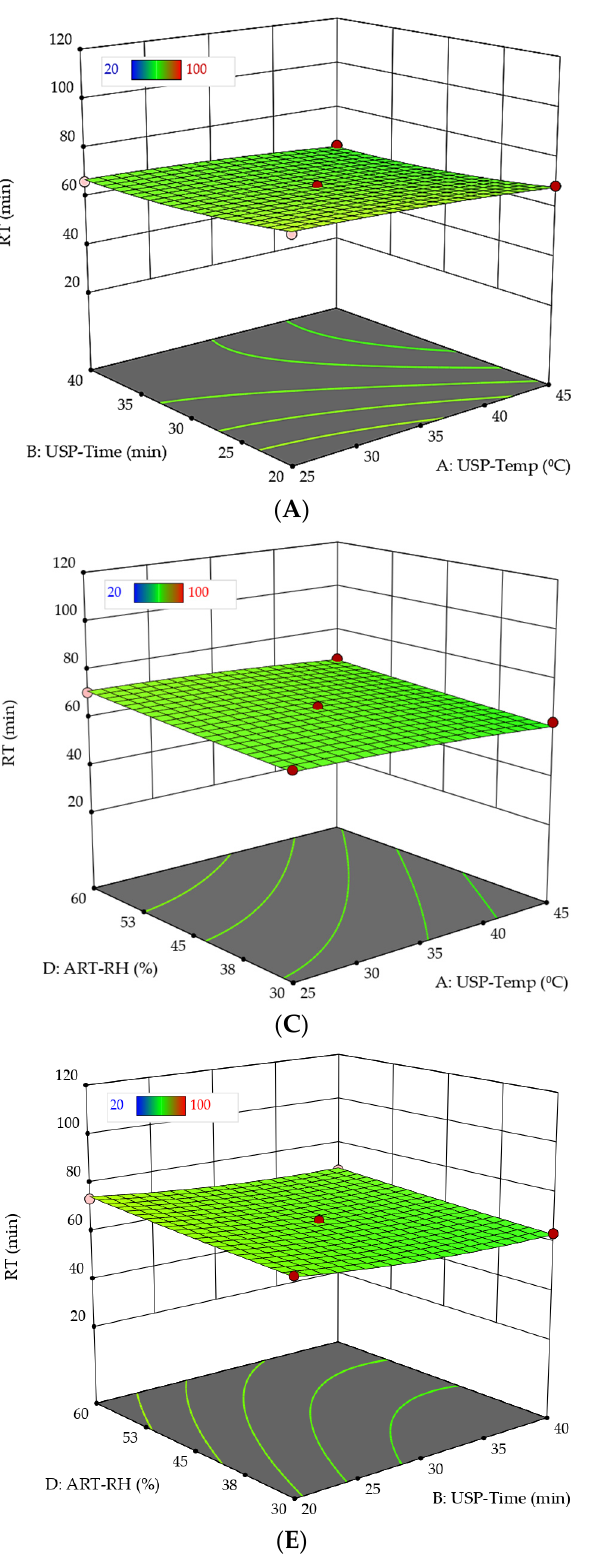
Figure 8. 3D response surface plots representing the effect of A: USP-Temp (ultrasound pretreatment time) and B: USP-Time (ultrasound pretreatment temperature) ( A ), A: USP-Temp and C: ART-Temp (ripening treatment temperature) ( B ), A: USP-Temp and D: ART-RH (ripening treatment RH) ( C ), B: USP-Time and C: ART-Temp ( D ), B: USP-Temp and D: ART-RH ( E ), C: ART-Temp and D: ART-RH ( F ) on the required time for fruit ripening (RT).